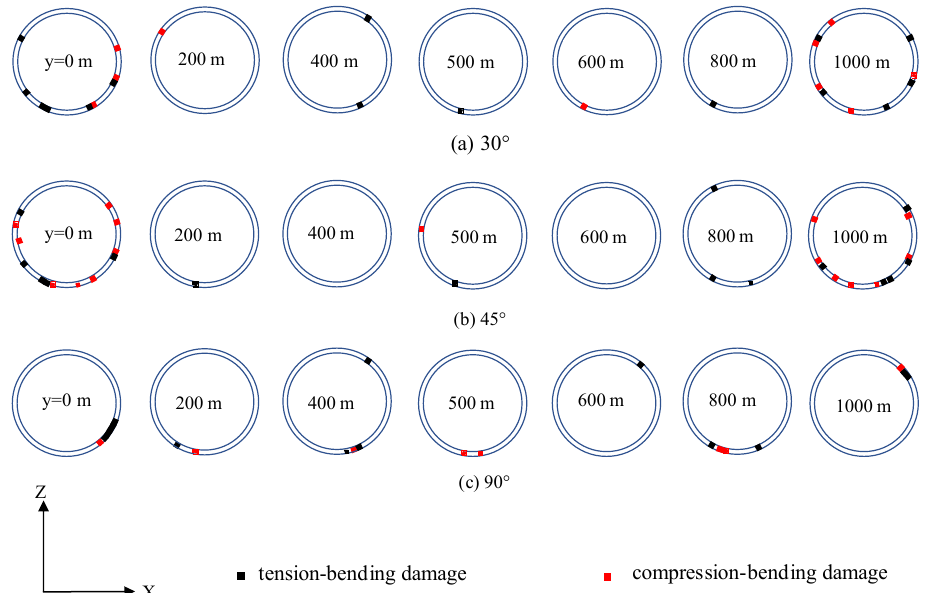
Figure 16. Schematic diagram of lining failure crossing different inclinations of adverse geological structure zone at different sections along the tunnel axis.